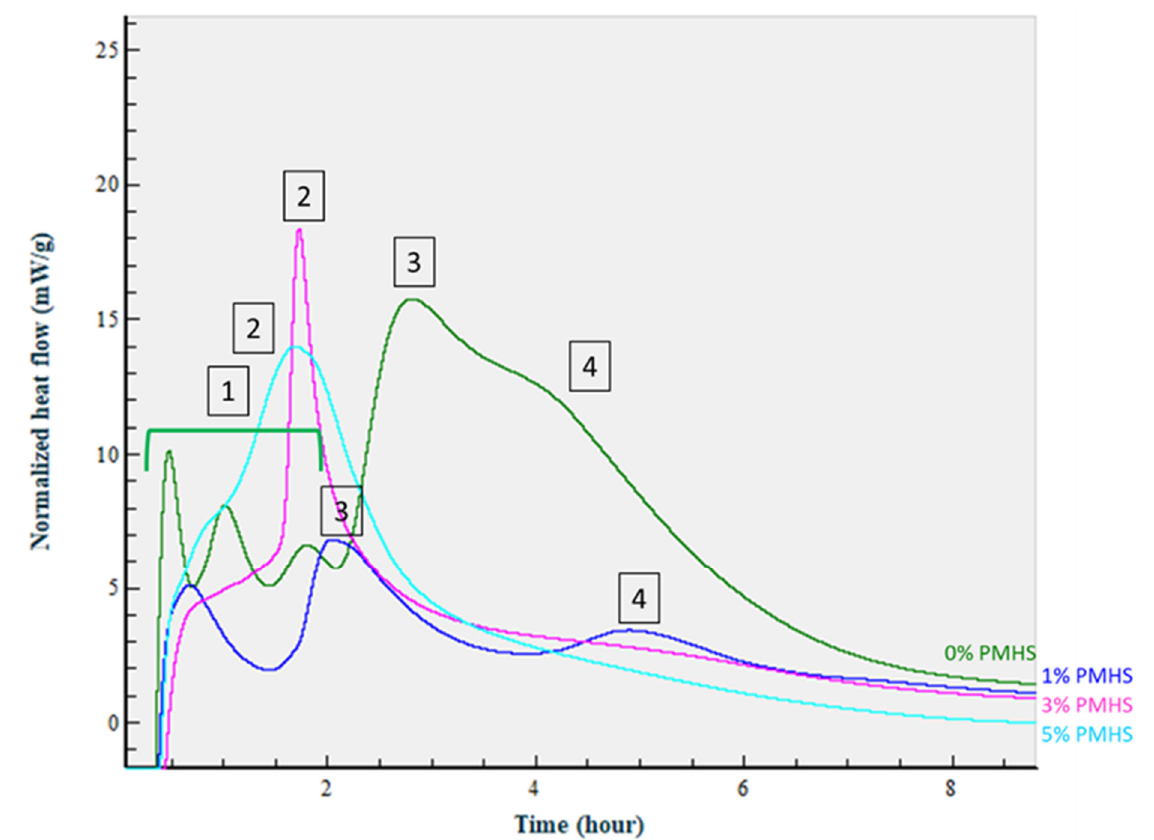
Figure 19. Normalized heat-flow curves at 85 °C isothermal temperature for lightweight cement slurries prepared with 0, 1, 3, and 5% PMHS-treated FCS/SMS and CAC.